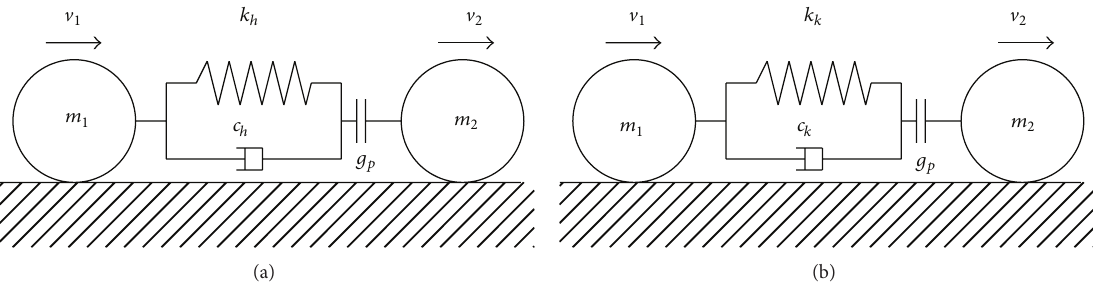
Figure 1: Equivalent model of impact between two colliding bodies: (a) system 1 with Hertz-damp model and (b) system 2 with Kelvin model.